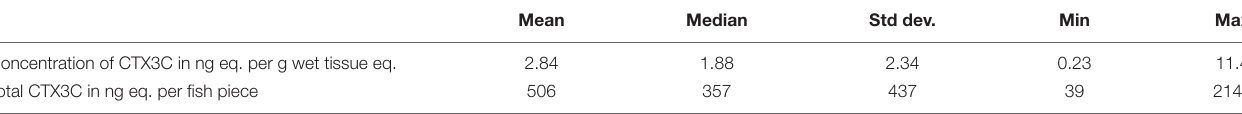
TABLE 2 | Toxin content description for recalled fish filet samples ( n = 45) in CTX3C equivalent (eq.). Mean Median Std dev. Min Max Concentration of CTX3C in ng eq. per g wet tissue eq.